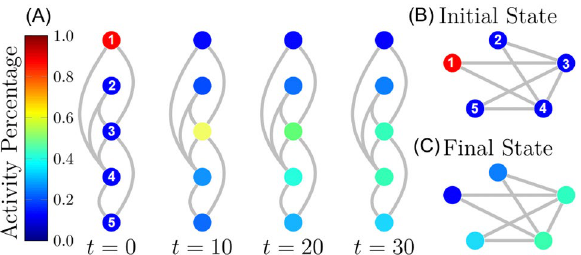
Figure 1. An example of continuous risk dynamics. Continuous risk dynamics simulated on a subnetwork from the World Economic Forum’s Global Economy Risk Network. In order of the numerical labels in the figure, these nodes represent inflation, failure of climate change mitigation, interstate conflict, large scale migration, and cyberattacks. No control is applied and we can see that all nodes are inactive at the beginning of the simulation except for inflation. The activity from inflation can be seen to disperse over the network until all nodes are at a low level of activity at the end of the